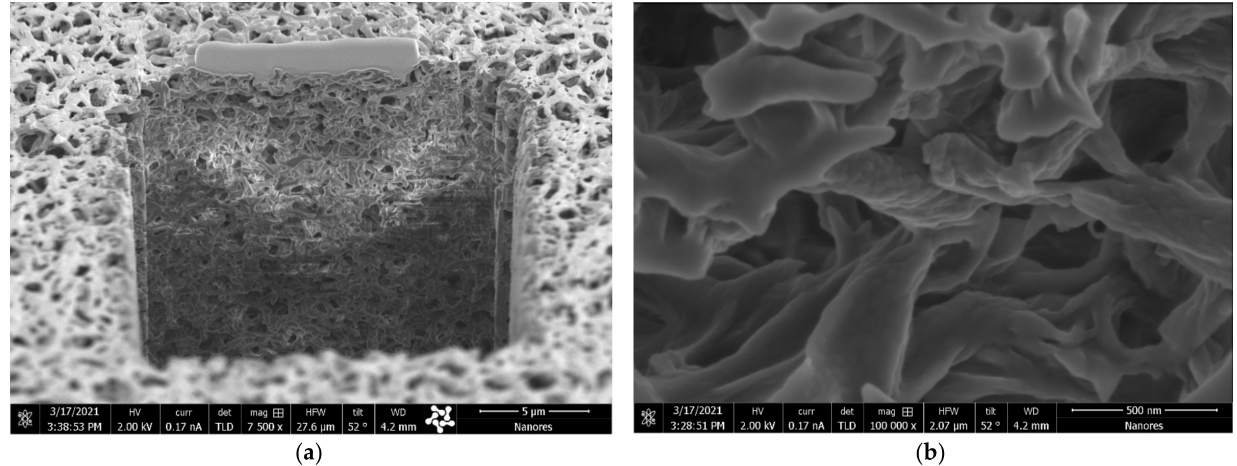
Figure A2. The cross section of a polyamide membrane exposed to pure scCO 2 at 15 MPa and 40 ◦ C for 3 h (bar = 5 µ m ( a ), bar = 500 nm ( b )). The bump-like structure of the virgin polymer is visible in the micrograph ( b ). Unpublished material from the study